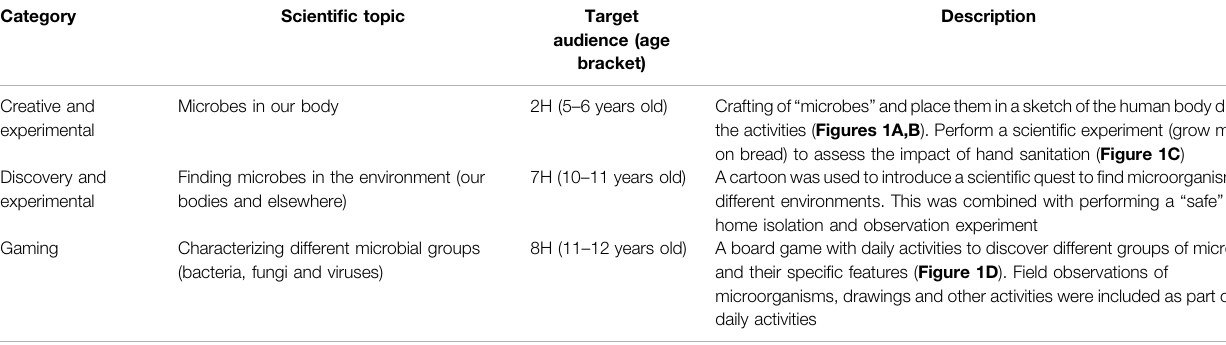
TABLE 1 | Service-learning activities proposed in 2020. For each activity, the category, scienti fi c topic, target audience (standard school level according to harmonized -HarmoS- educational level de fi ned by the « Conférence suisse des directeurs cantonaux de l ’ instruction publique (CDIP) »), and a brief description of the activity are